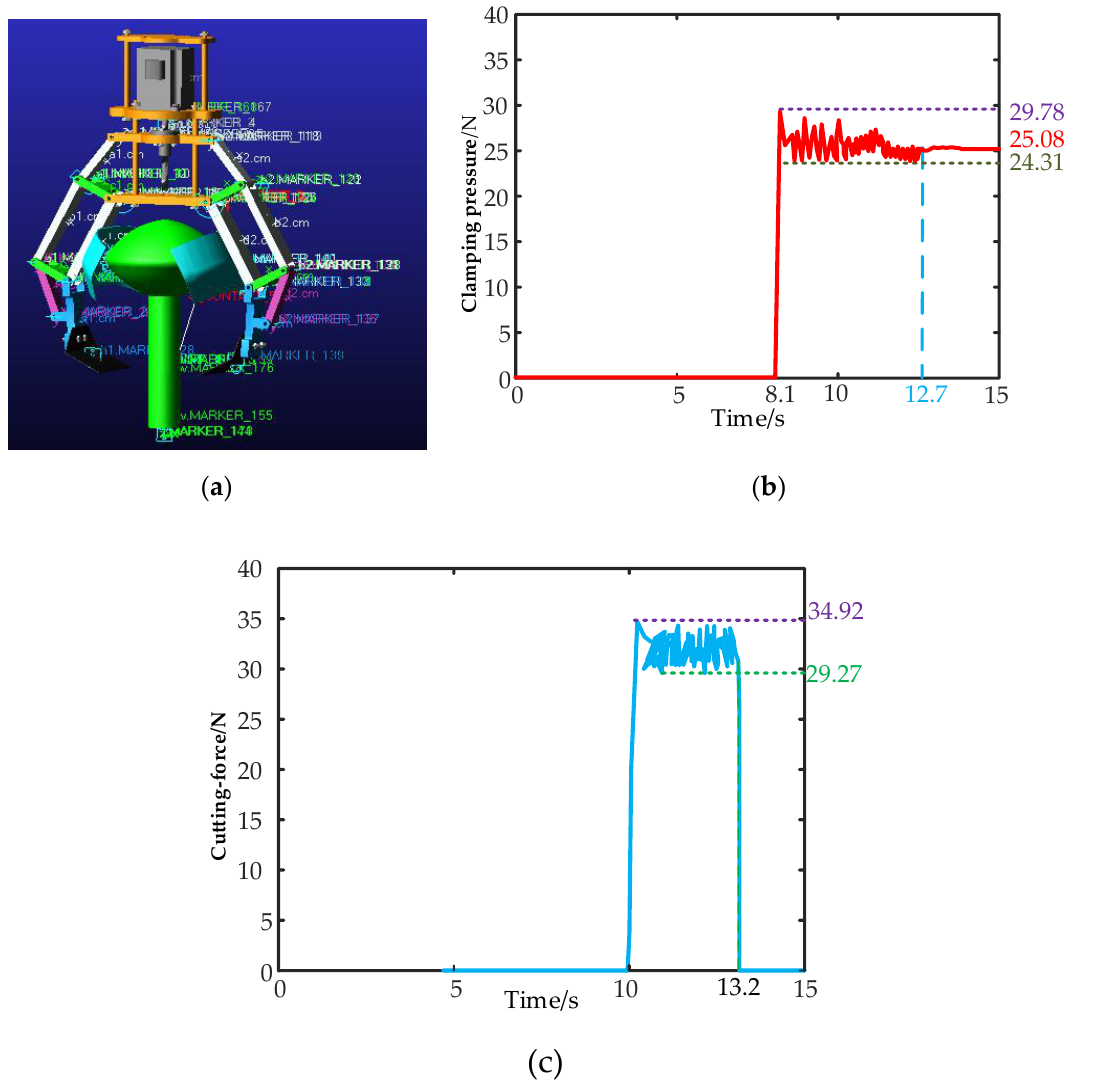
Figure 10. Manipulator motion simulation: ( a ) Manipulator motion simulation; ( b ) Clamping pressure curve; ( c ) Cutting force curve.